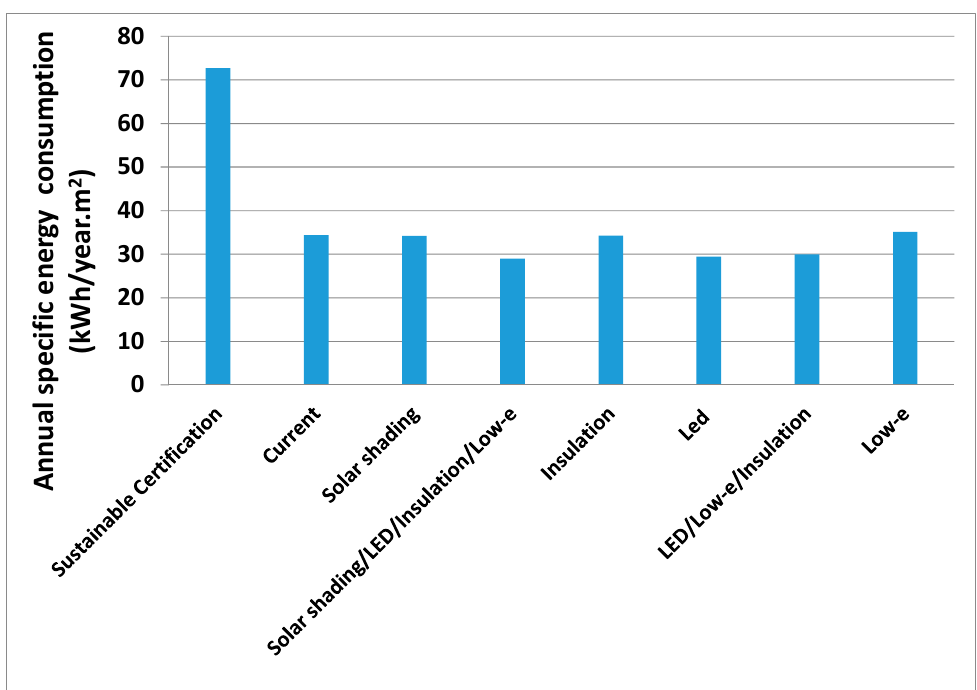
Figure 18. Annual specific energy consumption of the building with and without retrofit interventions. Table 13. Annual specific energy consumptions reported for administrative University